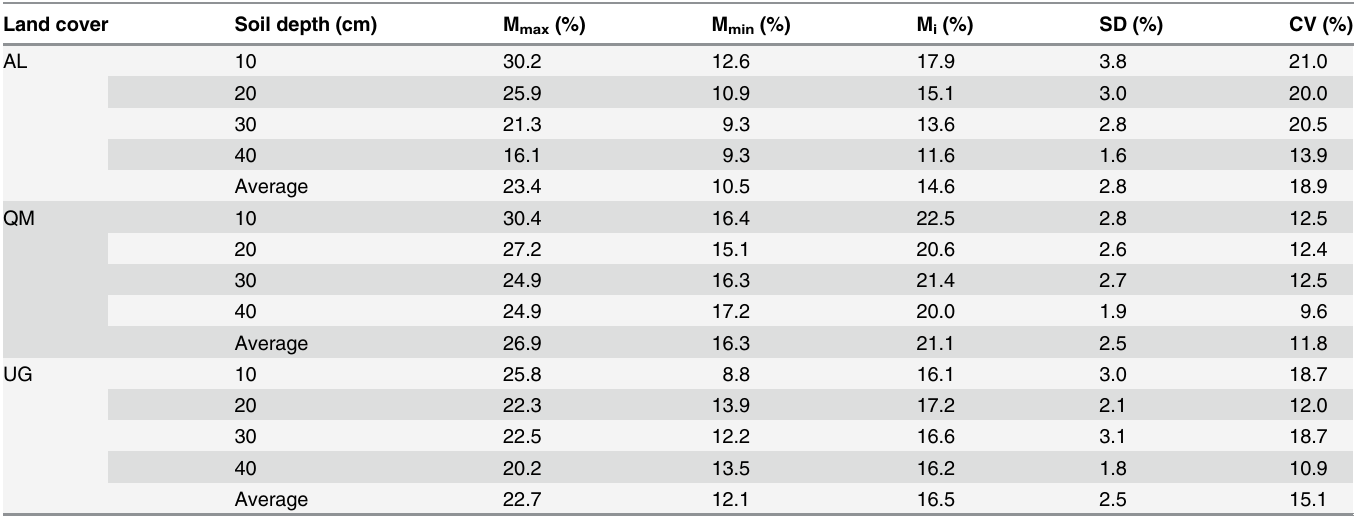
Table 3. Soil-moisture content at each soil depth for the three vegetation types from June to September. Land cover Soil depth